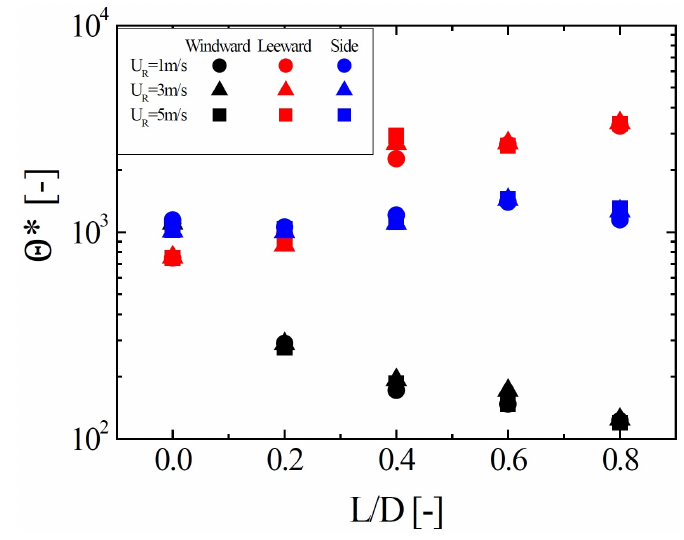
Figure 11. Effect of the overhang length ( L / D ) on the normalized volume–averaged